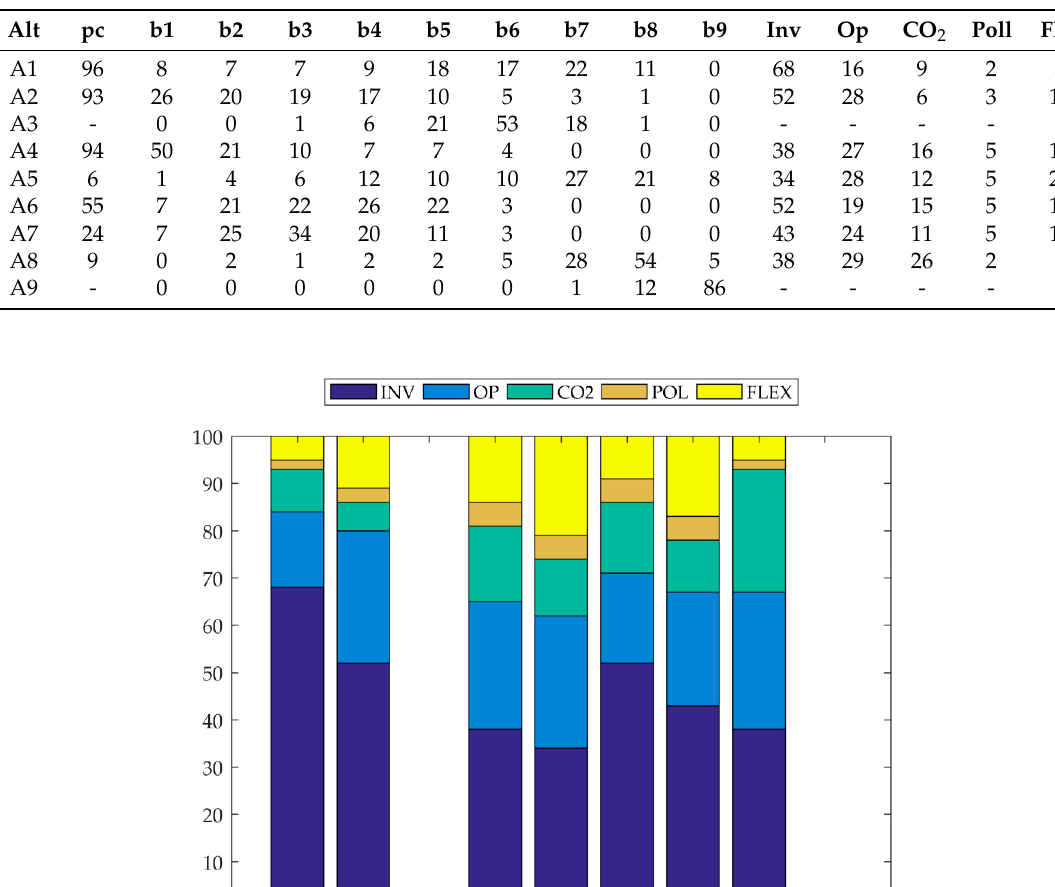
Figure 6. Rank acceptability indices of alternatives (%). Table 8. Confidence factor, rank acceptability indices and central weights for the alternatives.